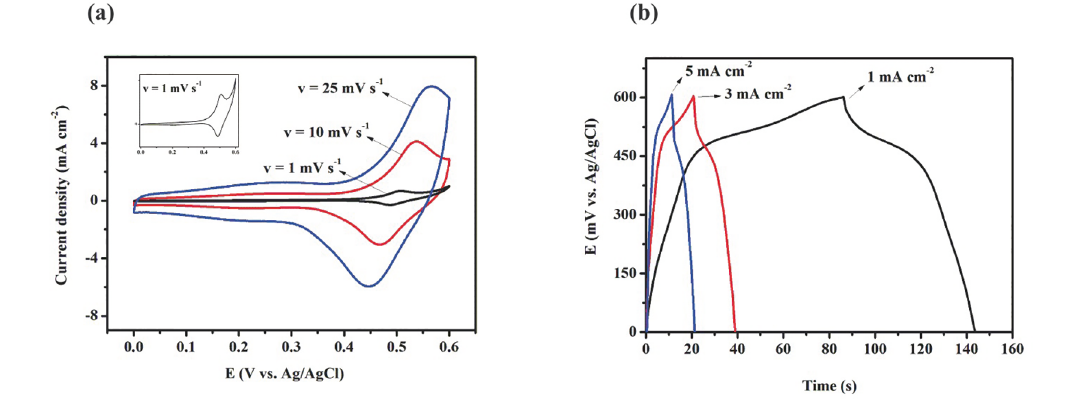
Figure 2. (a) Cyclic voltammograms at 1, 10 and 25 mV s -1 and (b) Charge-discharge at 1, 3 and 5 mA cm -2 at 1 mol L -1 of KOH for the